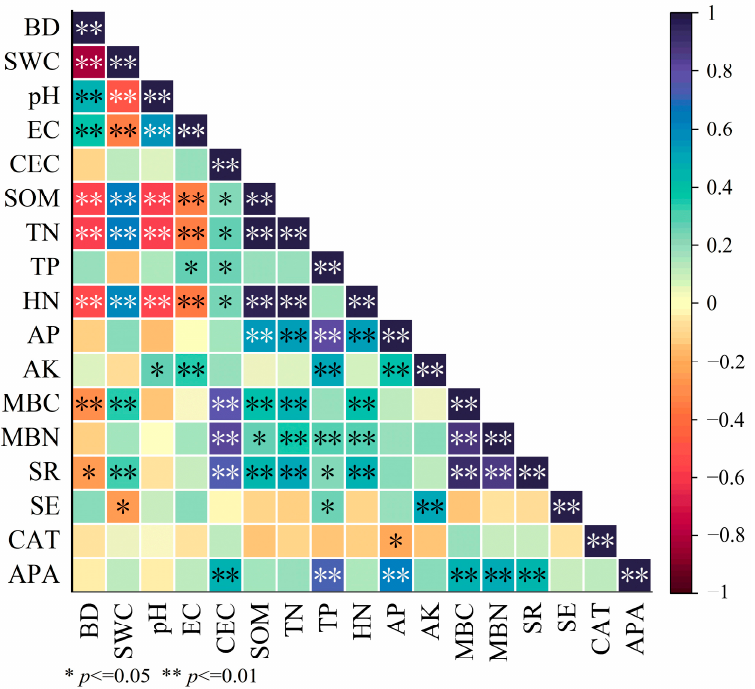
Figure 3. Heat map of the overall correlations between the soil biological indicators and soil physico- chemical indicators for typical farmland in the different regions. BD: Bulk density; SWC: Soil water content; EC: Electrical conductivity; CEC: Cation exchange capacity; SOM: Soil organic matter; TN: Total nitrogen; TP: Total phosphorus; HN: Hydrolysable nitrogen; AP: Available phosphorus; AK: Available potassium.